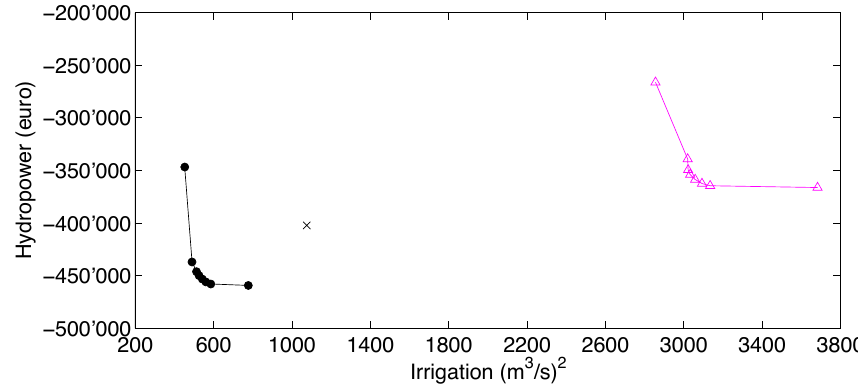
Fig. 5. Image of the Pareto Frontier (IPF) under historical inflow 1967–1980 (black dots) and forecast inflow scenario 2071–2100 by RACMO RCM (magenta triangles). The cross is the historical management. Hydropower revenue (on the vertical axis) is changed in sign.